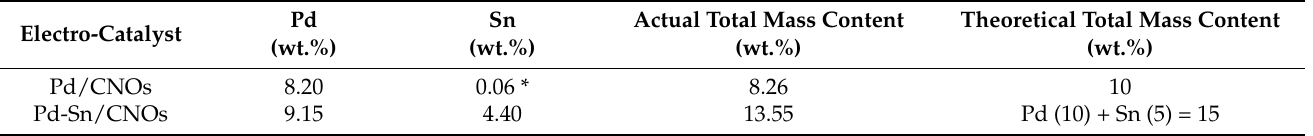
Table 5. Metal element loading of the synthesized